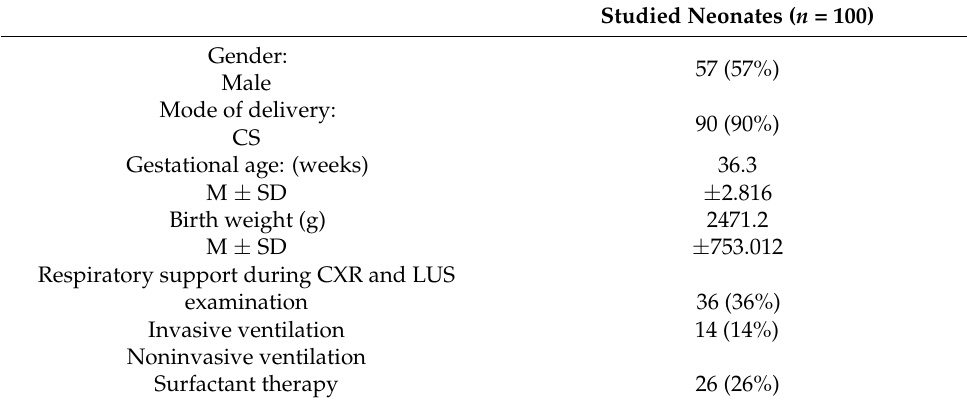
Table 1. Demographic and clinical data of the studied